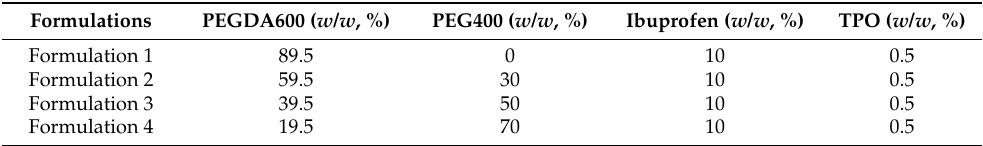
Table 1. Composition of formulations prepared for